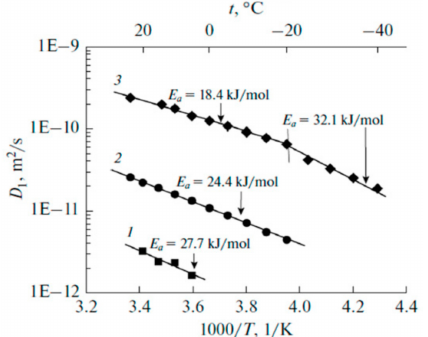
Figure 31. Temperature dependence of the diffusion coefficients D measured by pulsed field gradient NMR at different water contents in acid form of MSC membrane: λ = 5.1 ( 1 ), 7 ( 2 ), 8.4 ( 3 ). Reprinted with permission from [16]. Copyright 2020 Springer